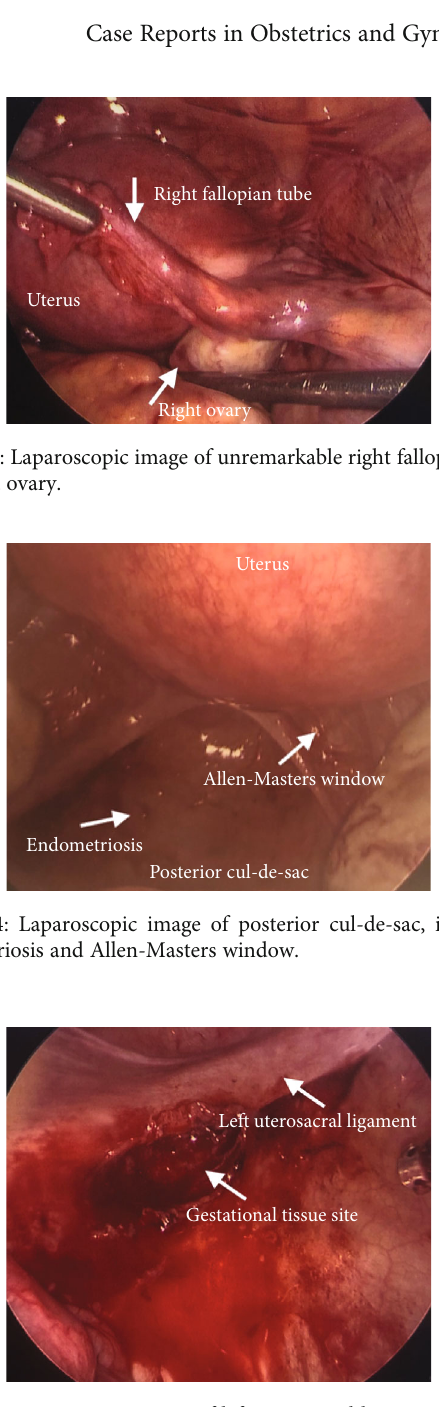
Figure 5: Laparoscopic image of left uterosacral ligament with the site of gestational